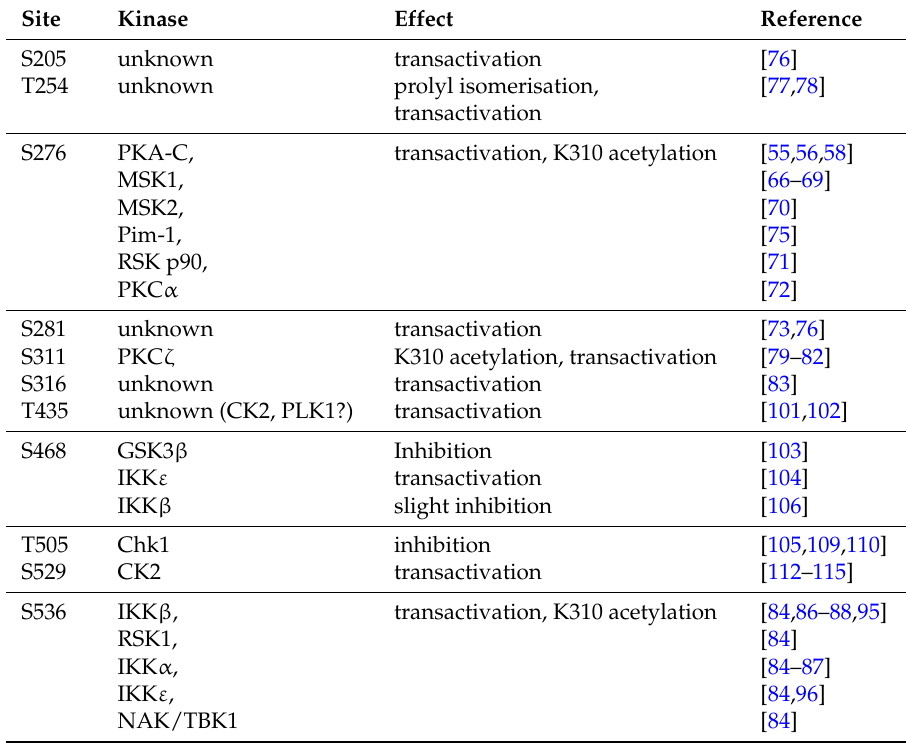
Table 3. Phosphorylations of the RelA/p65 NF- κ B